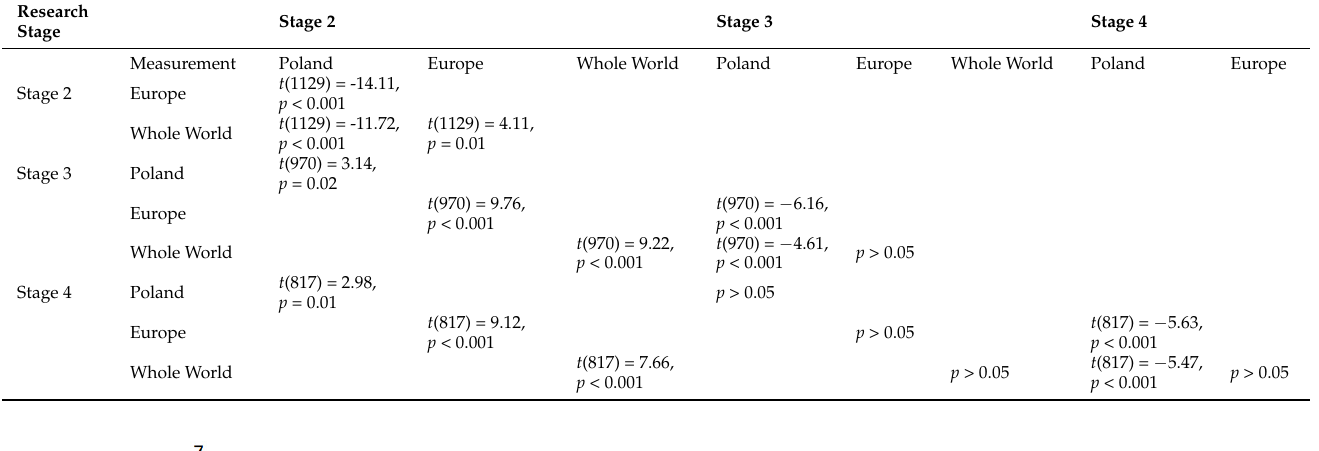
Table 3. t -test comparisons within the interaction of distance and study stage.